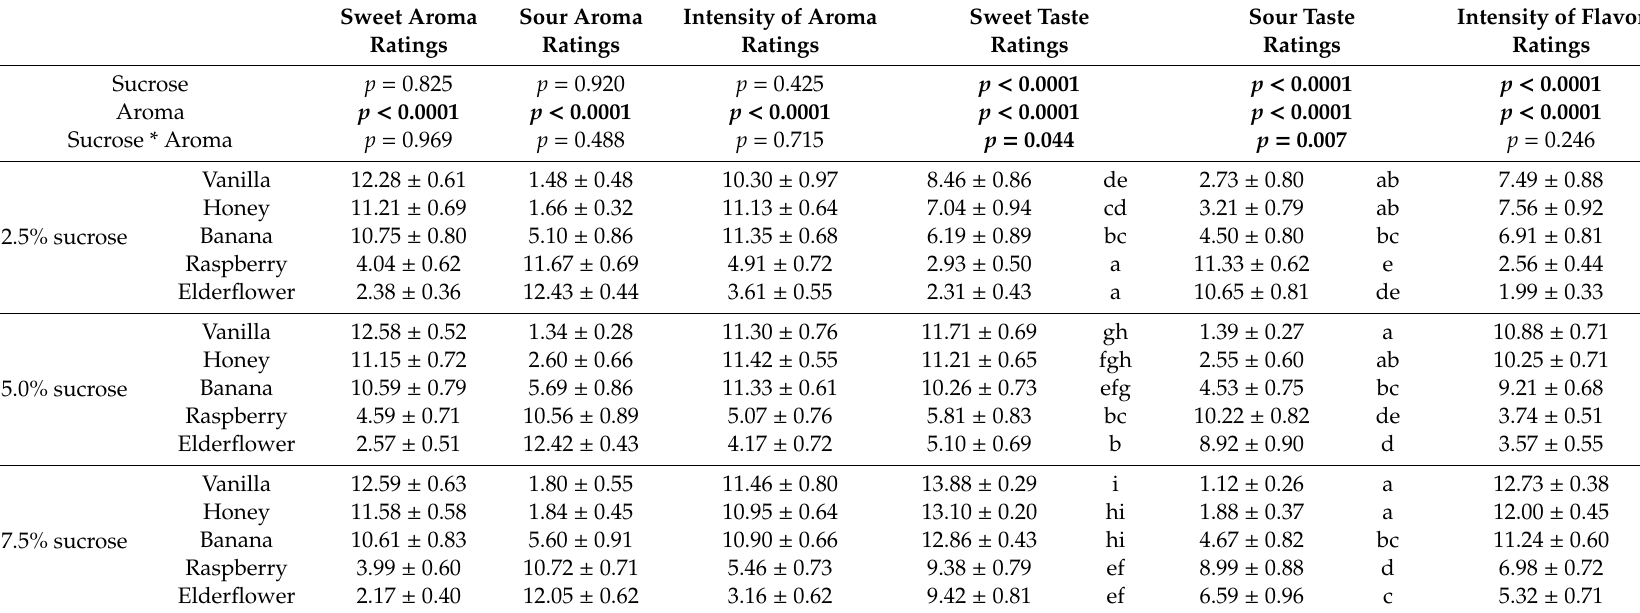
Table 2. Means ± standard (std.) errors and p -values for each design factor and attribute included in the DA. * indicates interaction. Significant e ff ects are marked in bold. For sweet and sour taste, significant di ff erences found with Tukey’s comparison test are indicated with letters. Samples sharing a letter in each column are not significantly di ff